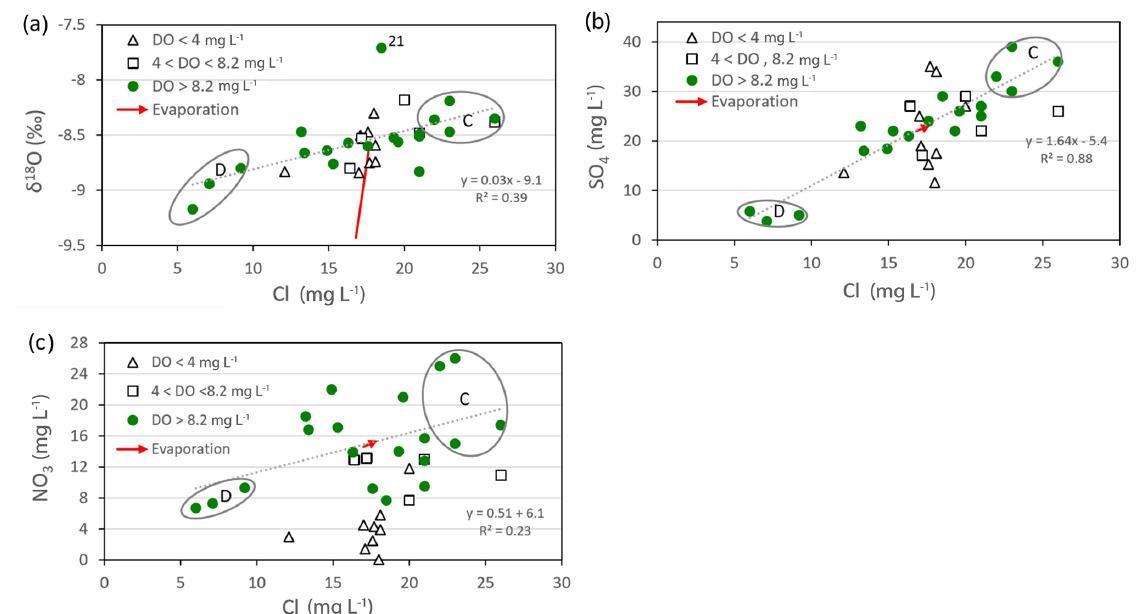
Figure 5. Plots of (a) chloride versus water δ 18 O, (b) chloride versus sulfate, and (c) chloride versus nitrate concentrations. Group C (with land surface irrigation recharge) and Group D (alpine-river recharge) are circled. The red arrow shows the predicted effect of evaporation.